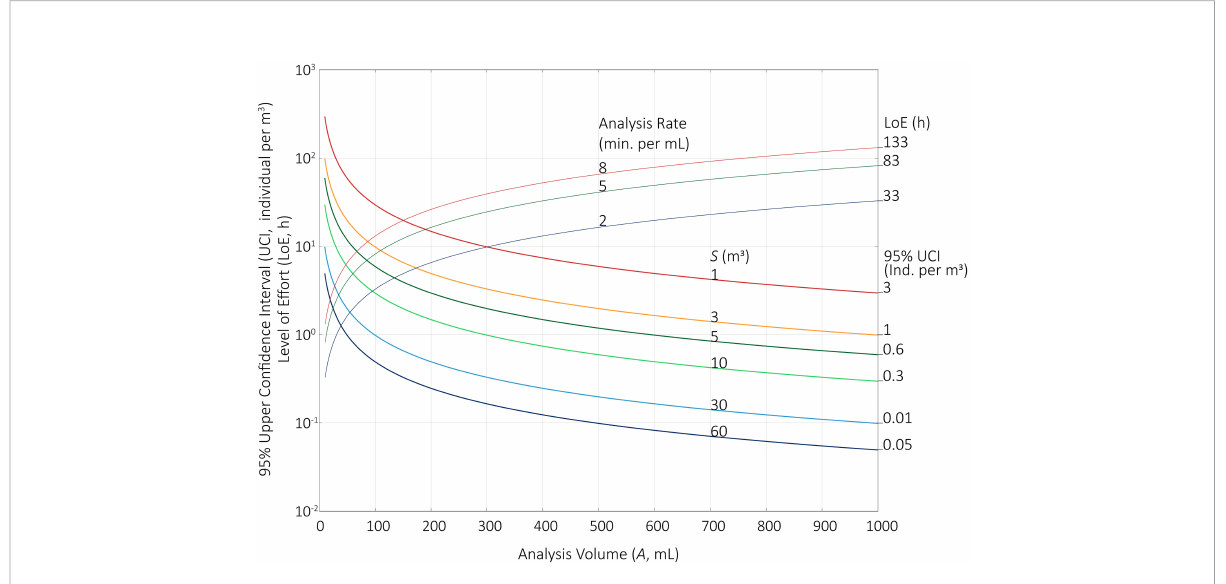
calculated for the range of A , with counting rates of 2-, 5-, and 8-min. per mL per person. Maximum 95% upper CIs and maximum LoEs are listed where A = 1000